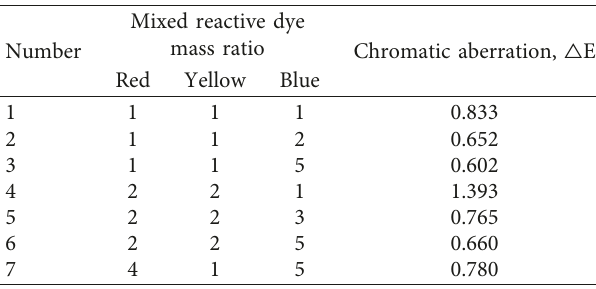
Table 1: Predicting formula color difference based on the Friele